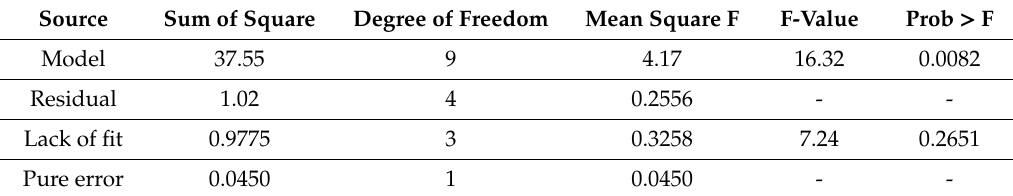
Table 8. Analysis of variance (ANOVA) results for KA